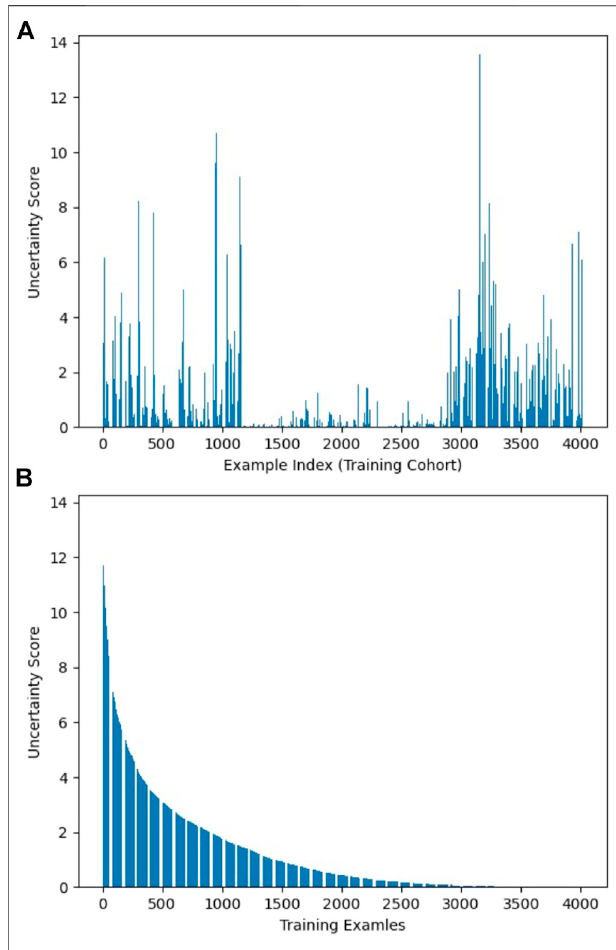
FIGURE 2 | Visualization of uncertainty distribution of training dataset: (A) unsorted and (B)